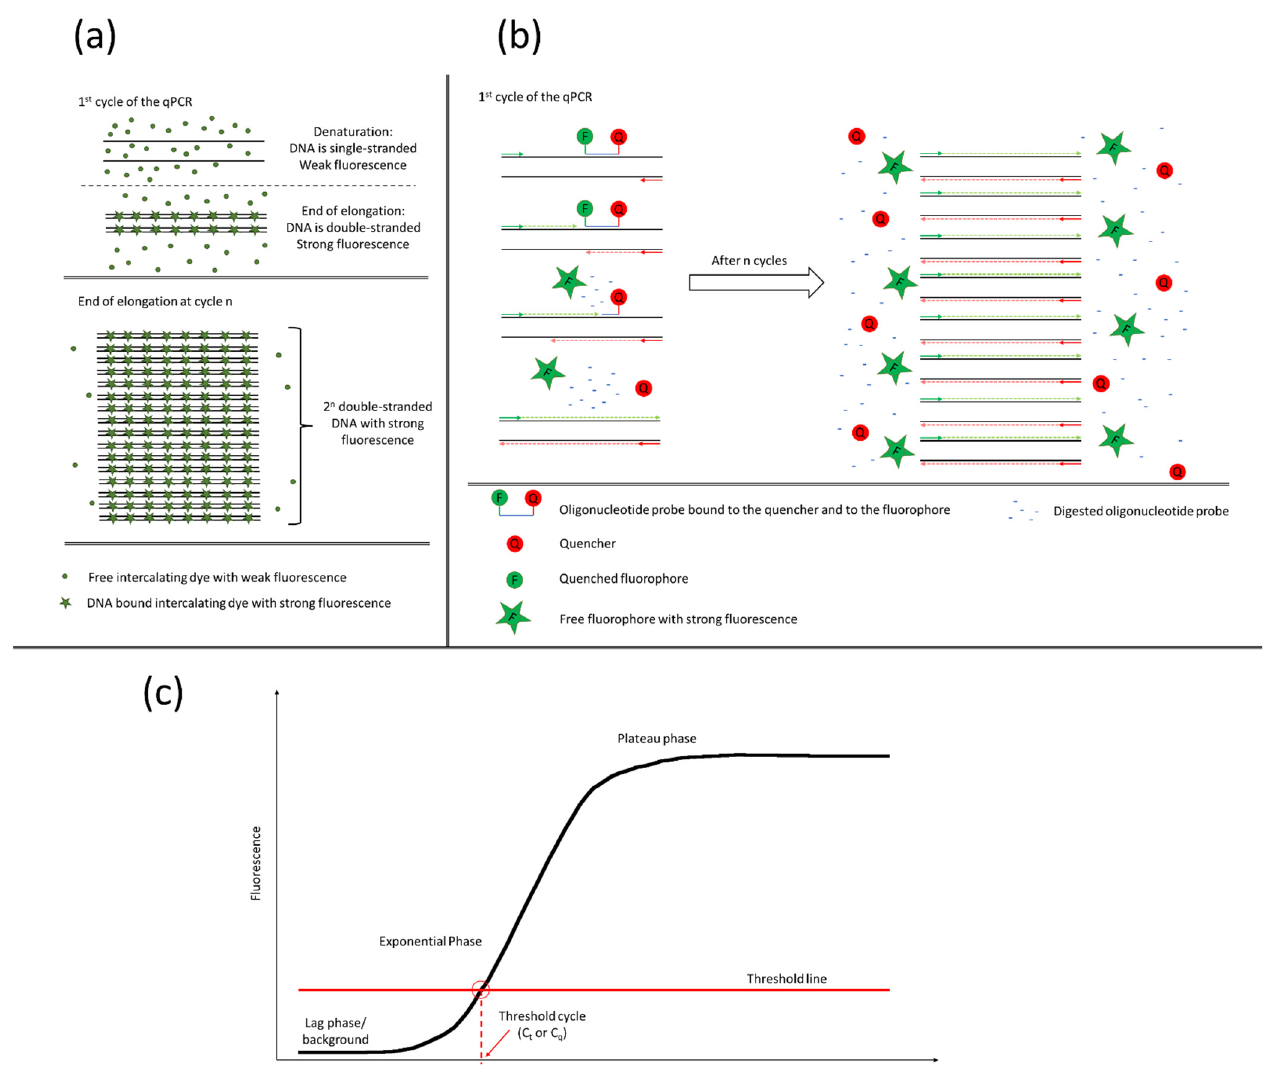
Figure 1. Change in fluorescence during qPCR: Panel ( a ) depicts the reason for increasing fluorescence through the cycles of qPCR using intercalating dye. The dye has only weak fluorescence if not bound by DNA. At the end of each cycle where the products are present in double-stranded form, the intercalating dye binds the DNA and emits a strong light. More double-stranded products mean stronger fluorescence. Panel ( b ) shows the principles of probe-based qPCR. The probe-based qPCR approach uses target-specific oligonucleotide probes labelled with a fluorescent dye and a quencher molecule. During the synthesis of the new strand, the DNA polymerase digests the probe, setting free the fluorophore and the quencher. The fluorophore moves away from the quencher and starts emitting light. Both qPCR techniques result in similar fluorescent curves, as shown on panel ( c ). The curve can be split into 3 main phases. The first phase is the lag phase, where only the background noise is detected. In the second phase, the fluorescence increases exponentially, and runs fast into the plateau phase. In the plateau phase, the fluorescence stops increasing due to the depleted reagents. The threshold line cuts the curve in the exponential phase defining the threshold cycle.